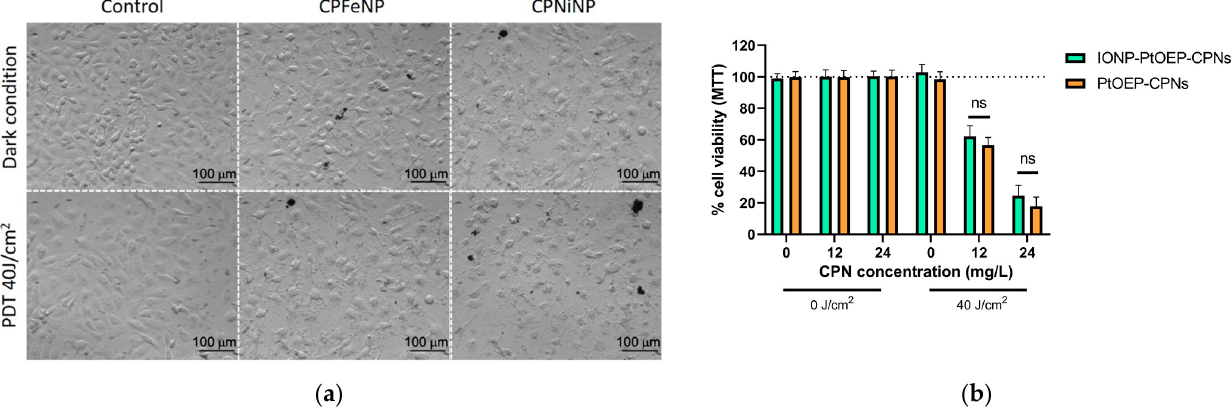
Figure 3. Photodynamic therapy of GBM in vitro using PtoEP-doped CPNs with and without IONPs. ( a ) Brightfield images of GBM cell lines before (top line) and after (bottom line) light irradiation (460 nm, 40 J/cm 2 ) of PtOEP-IONPs-doped CPN (CPFeNP and CPNiNP). Control experiment in the absence of nanoparticles is also shown for comparison. ( b ) U-87 MG cell viability percentages quantified by MTT assay 24 h after PDT (see details in experimental section) using IONP-PtOEP-CPNs (green bars) and PtOEP-CPNs (orange bars) (ns = no statistically significant differences).